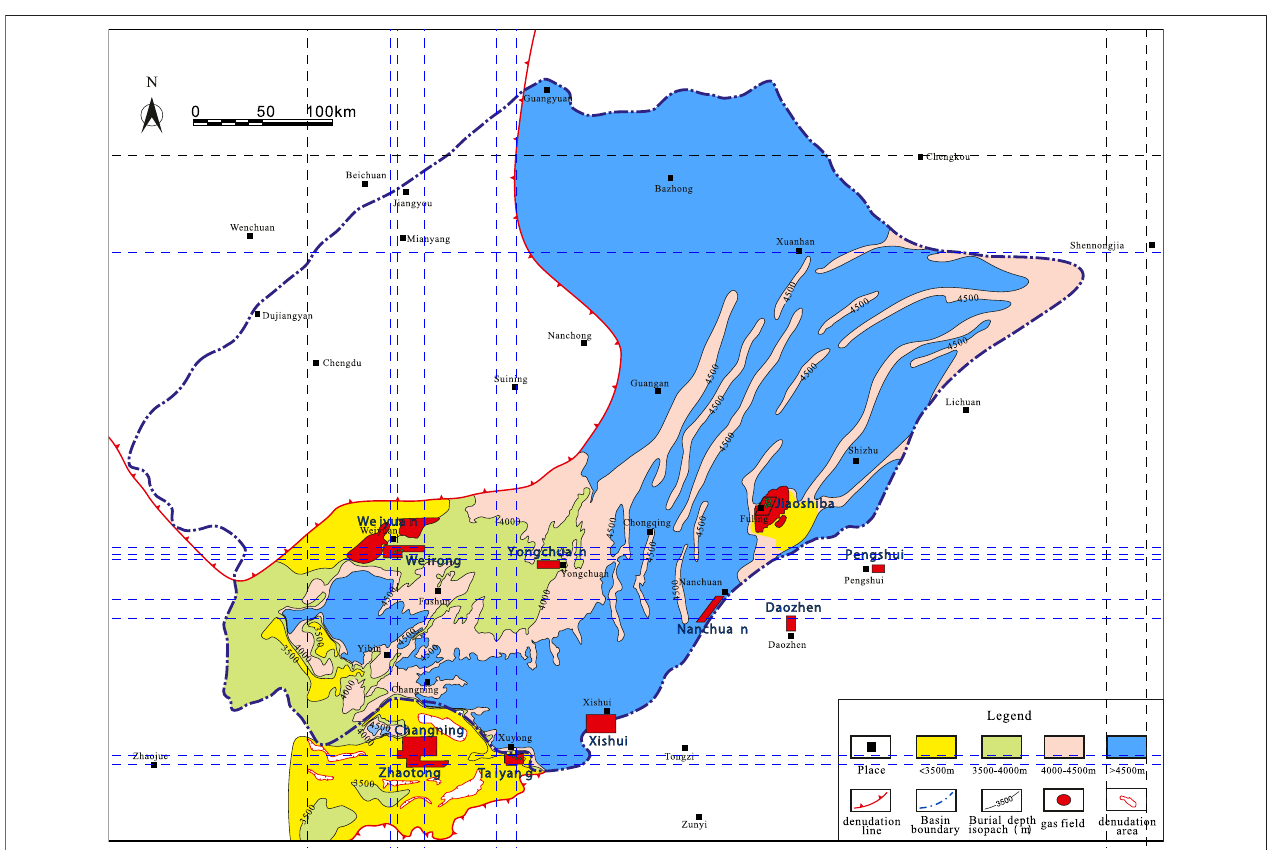
FIGURE1| LocationmapoftheTaiyang,Jiaoshiba,andWeironggas fi elds.Alsoshownaretheactualverticalburialdepths(excludingthehorizontalportion)ofthe Upper Ordovician Wufeng – Lower Silurian Longmaxi formations in the Sichuan Basin.